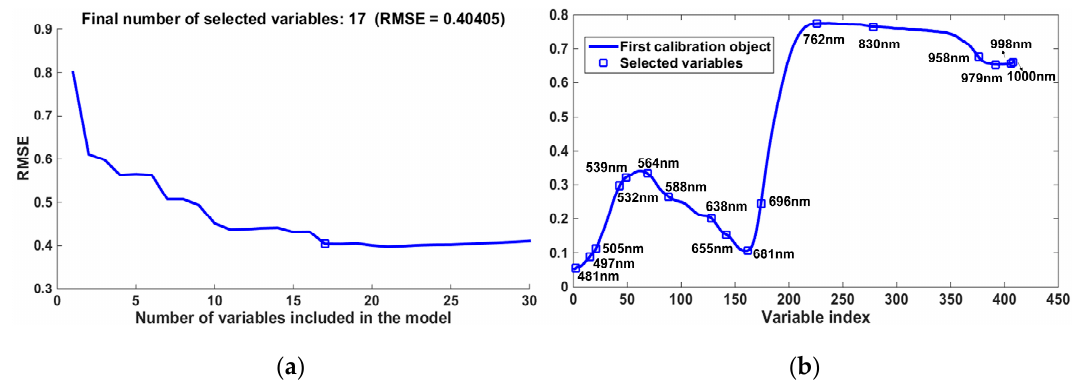
Figure 4. Selection of characteristic wavelengths by the successive projection algorithm (SPA): ( a ) numbers of characteristic wavelengths with the minimum root mean square error (RMSE); ( b ) distribution of characteristic wavelengths in the full band.